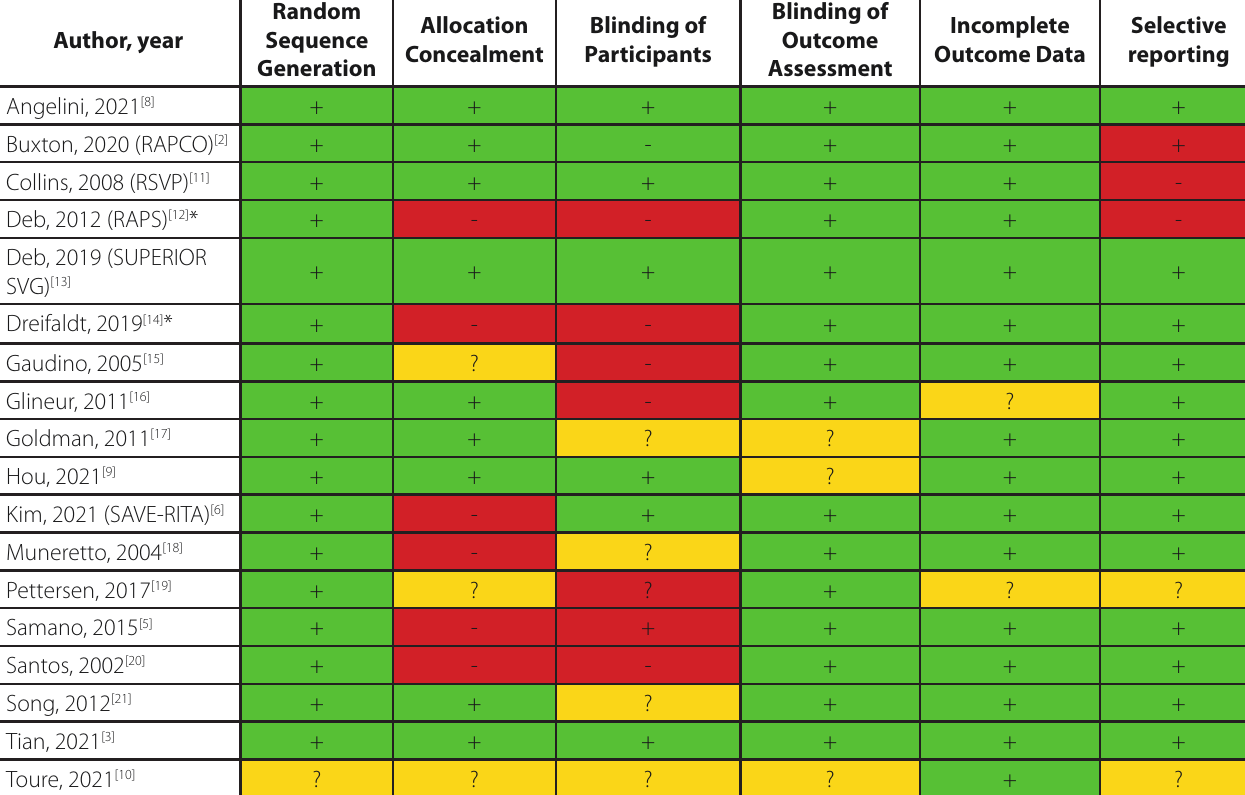
Table 5. Assessment of risk of bias using the Cochrane Collaboration’s tool. Author, year